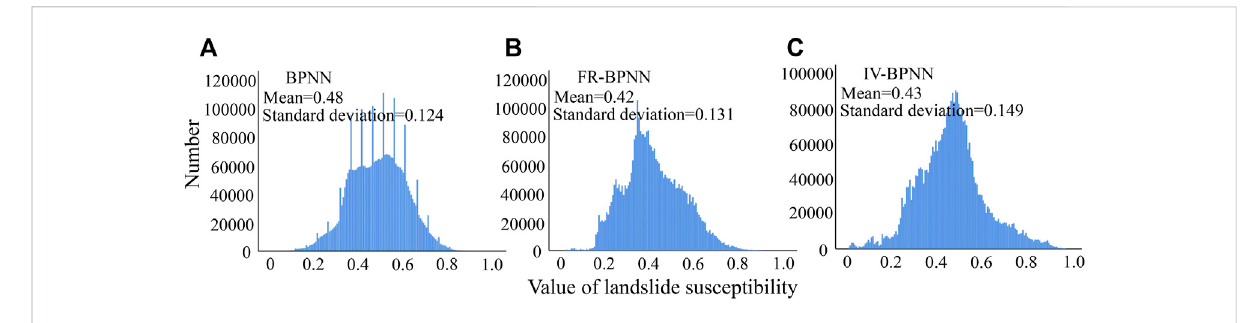
FIGURE 7 Distribution of landslide susceptibility